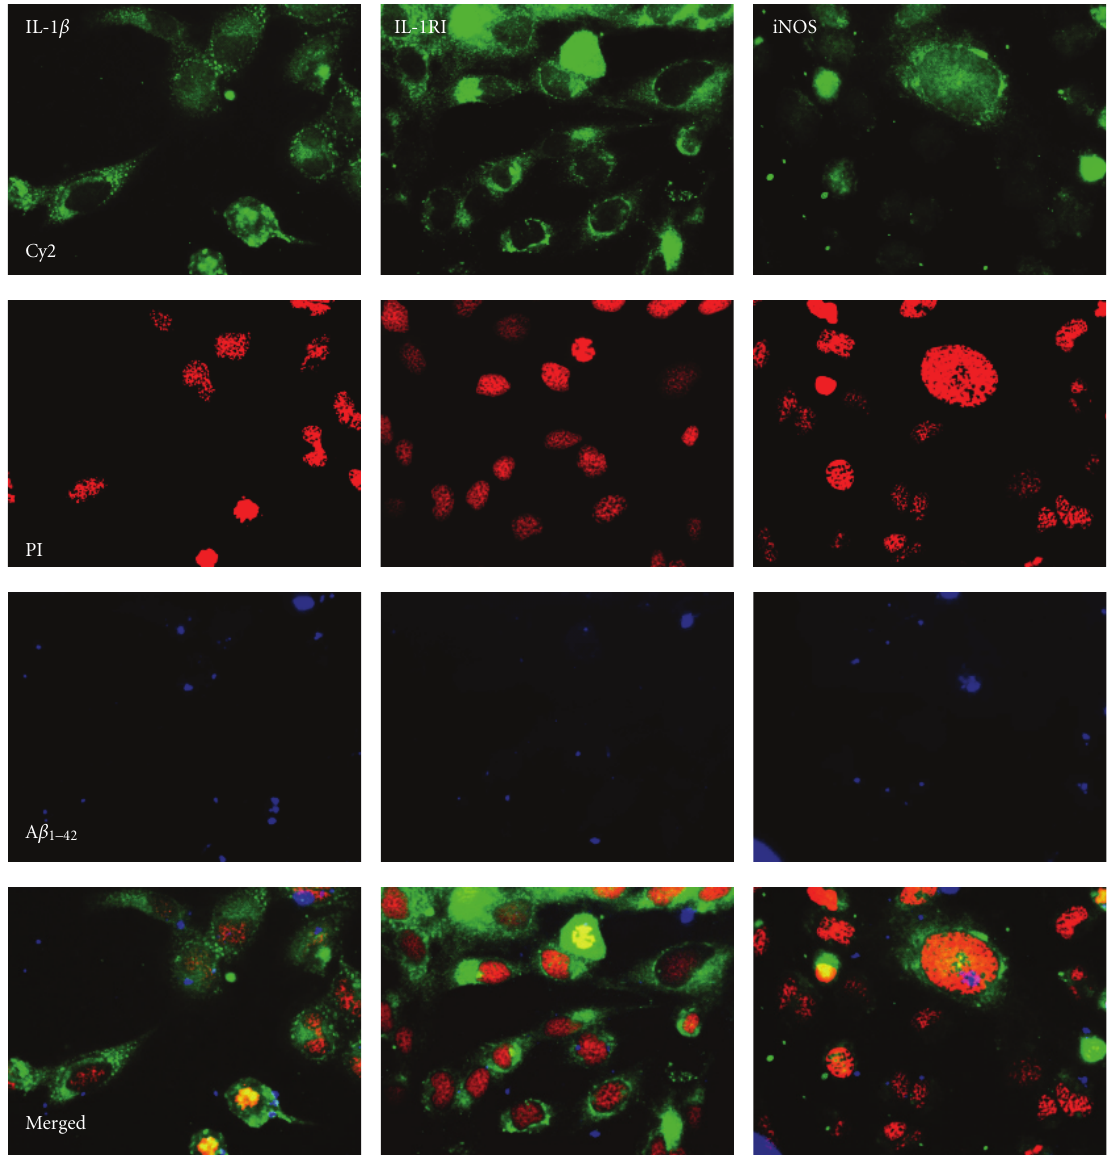
Figure 6: Uptake of A β 1 – 42 and expression of cellular markers in human microglial cells. The micrographs show human CHME3 microglial cells after incubation with biotinylated A β 1 – 42 , after which they were fixed and stained with antibodies against interleukin-1 β (IL-1 β ), IL-1 receptor type I (IL-1RI) and inducible nitric oxide synthase (iNOS), and subsequent incubation with Cy2-conjugated secondary antibodies. Cell nuclei were stained with propidium iodide (PI) and the biotinylated A β 1 – 42 was visualized with AMCA-conjugated streptavidin. All micrographs are in 20 ×